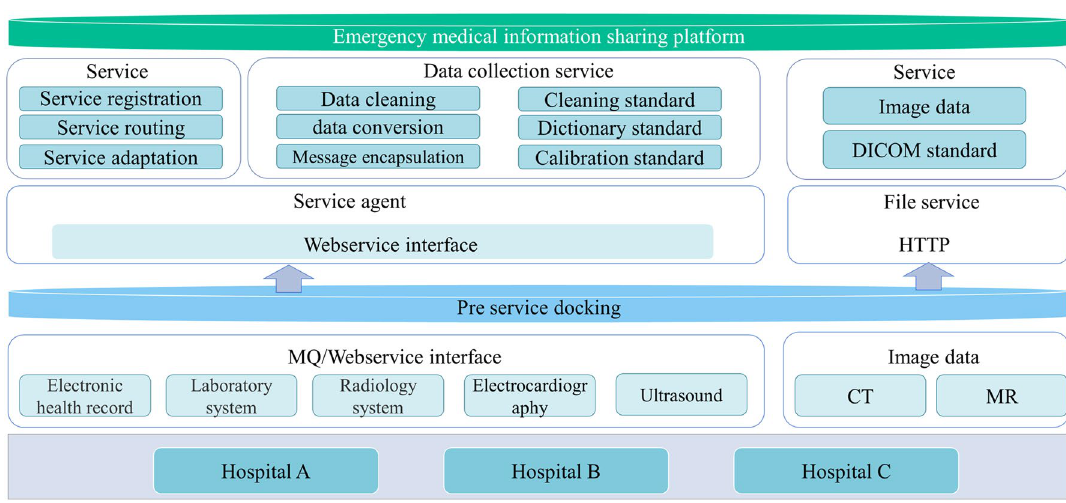
Figure 5. The front server-based medical information sharing platform’s interactive